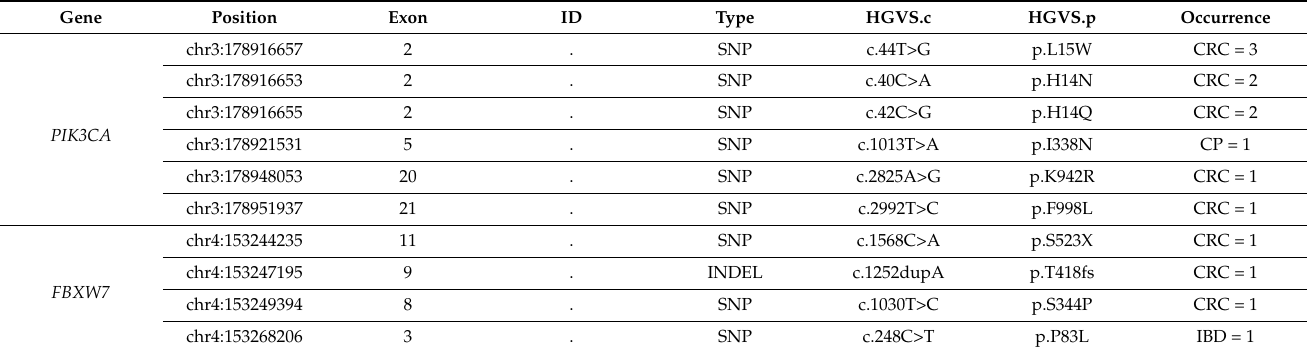
Table 3. Likely Novel Mutations detected in the cohort.